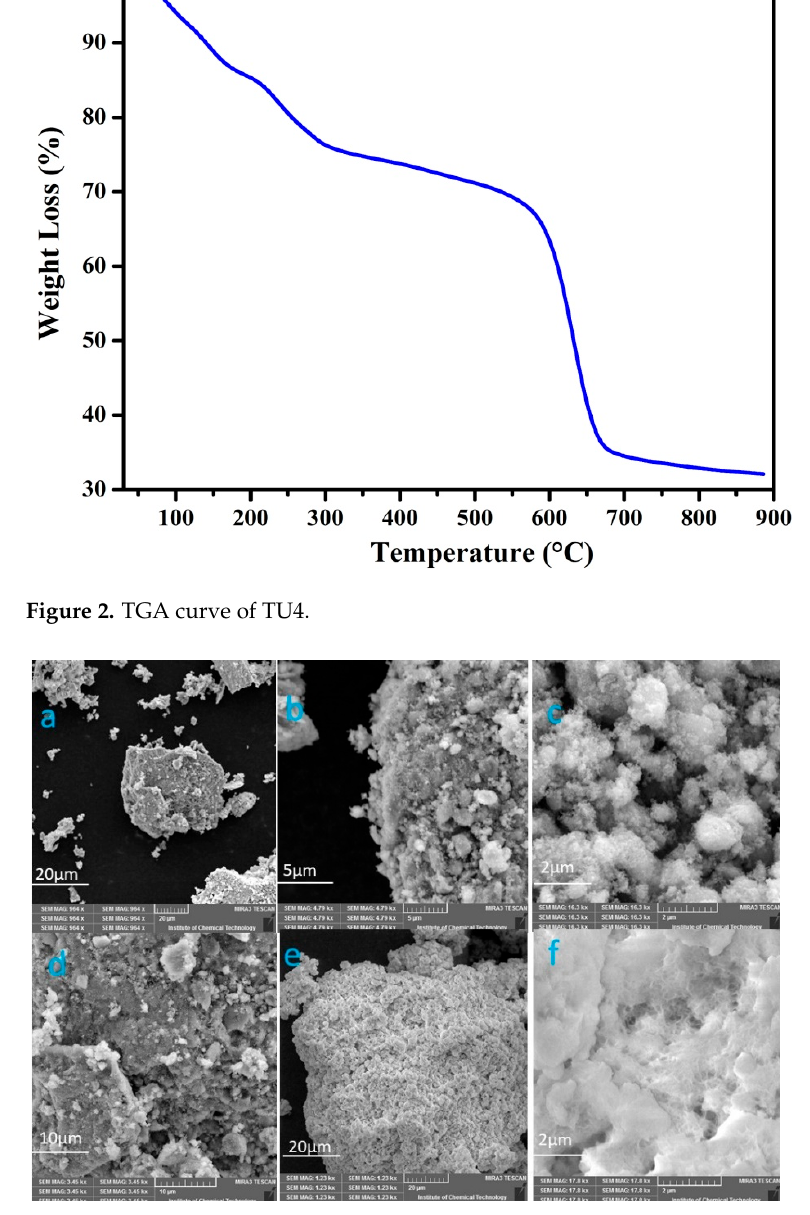
Figure 4. TEM images of ( a – d ) TU4. 3.4. Optical Properties Figure 5 presents the UV–Vis diffuse reflectance spectra of TiO 2 NPs. Maximum ab- sorption at 400 nm and a corresponding band gap of 3.10 eV for the TiO 2 NPs suggested that electron hole-pairs can be generated, although the TiO 2 NPs are irradiated with low energy visible light. This also reveals that the optical band gap of the TiO 2 NPs decreased considerably compared to its theoretical value of 3.20 eV [23]. The decrease of band gap can be attributed to different surface state defects [24,25]. The decrease in band gap is due to oxygen vacancies, which led to unique properties for photocatalytic applications [26]. The reduction in band gap is directly proportional to the photocatalytic activity, and TiO 2 NPs show greater activity in the visible region.